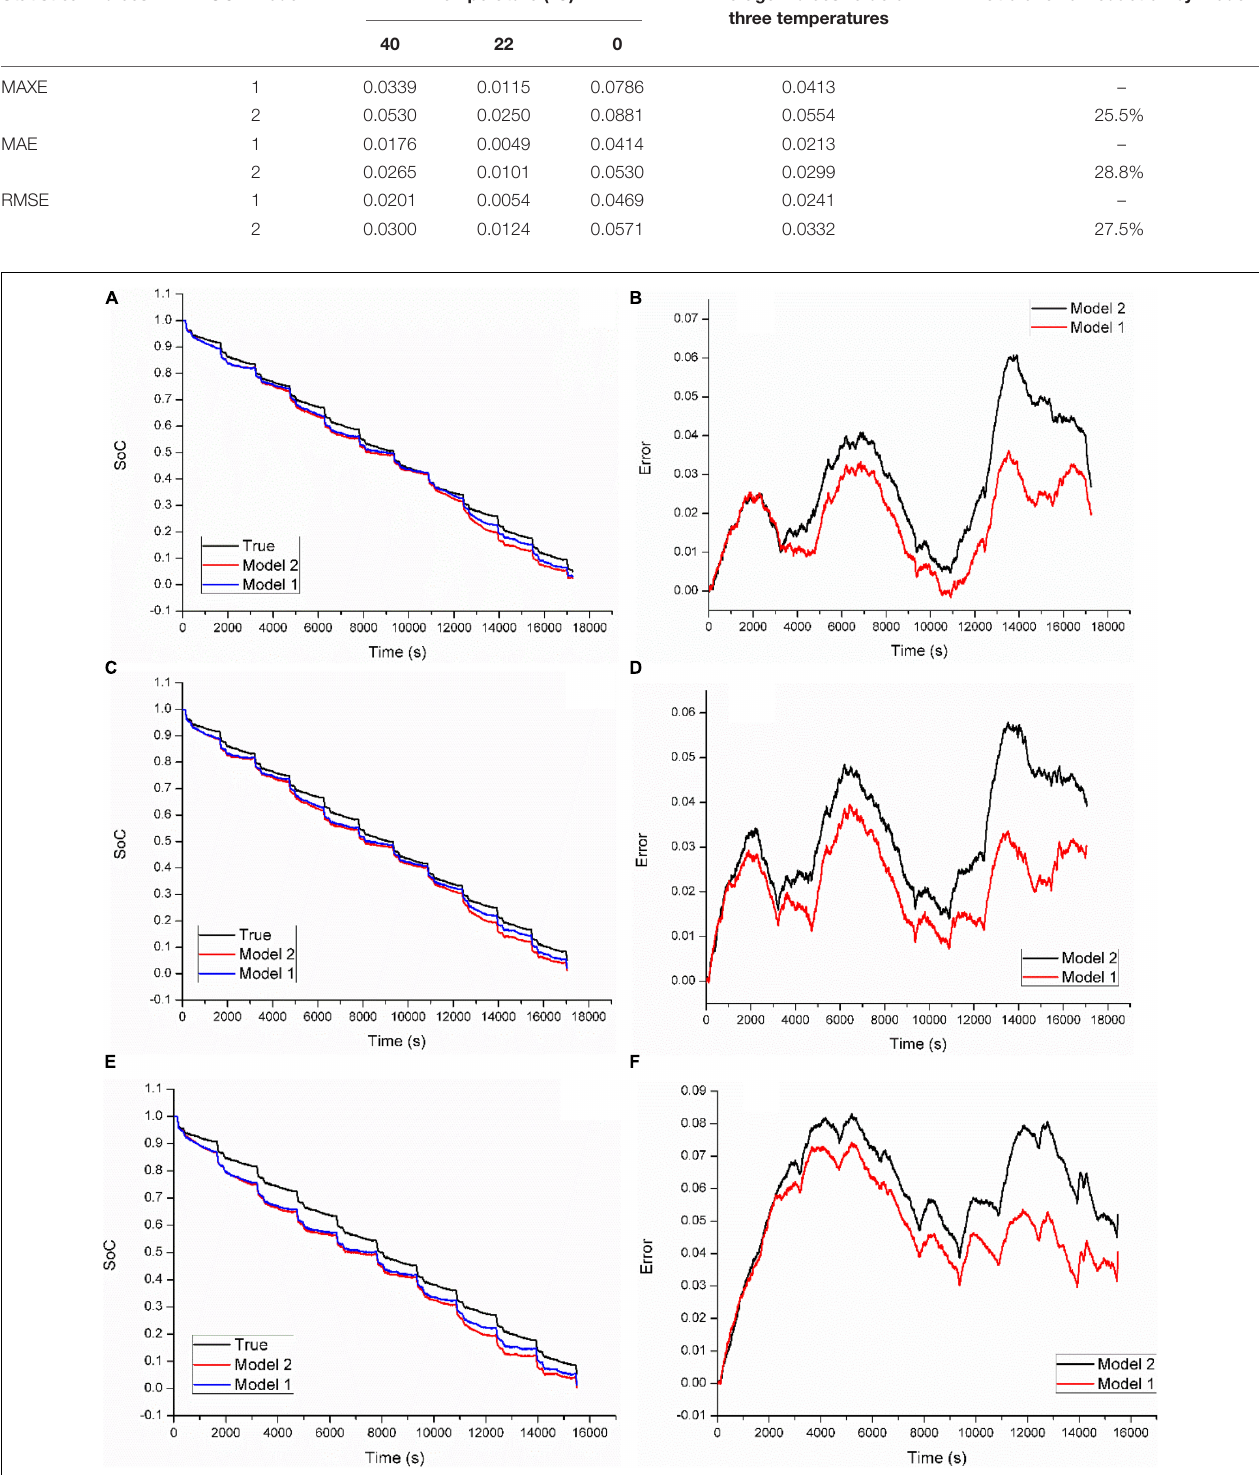
FIGURE 7 | Estimation results based on model 1 and model 2 at three temperatures via the UDDS. (A) Estimated SoCs at 40 ◦ C; (B) estimation errors at 40 ◦ C; (C) estimated SoCs at 22 ◦ C; (D) estimation errors at 22 ◦ C; (E) estimated SoCs at 0 ◦ C; (F) estimation errors at 0 ◦ C.